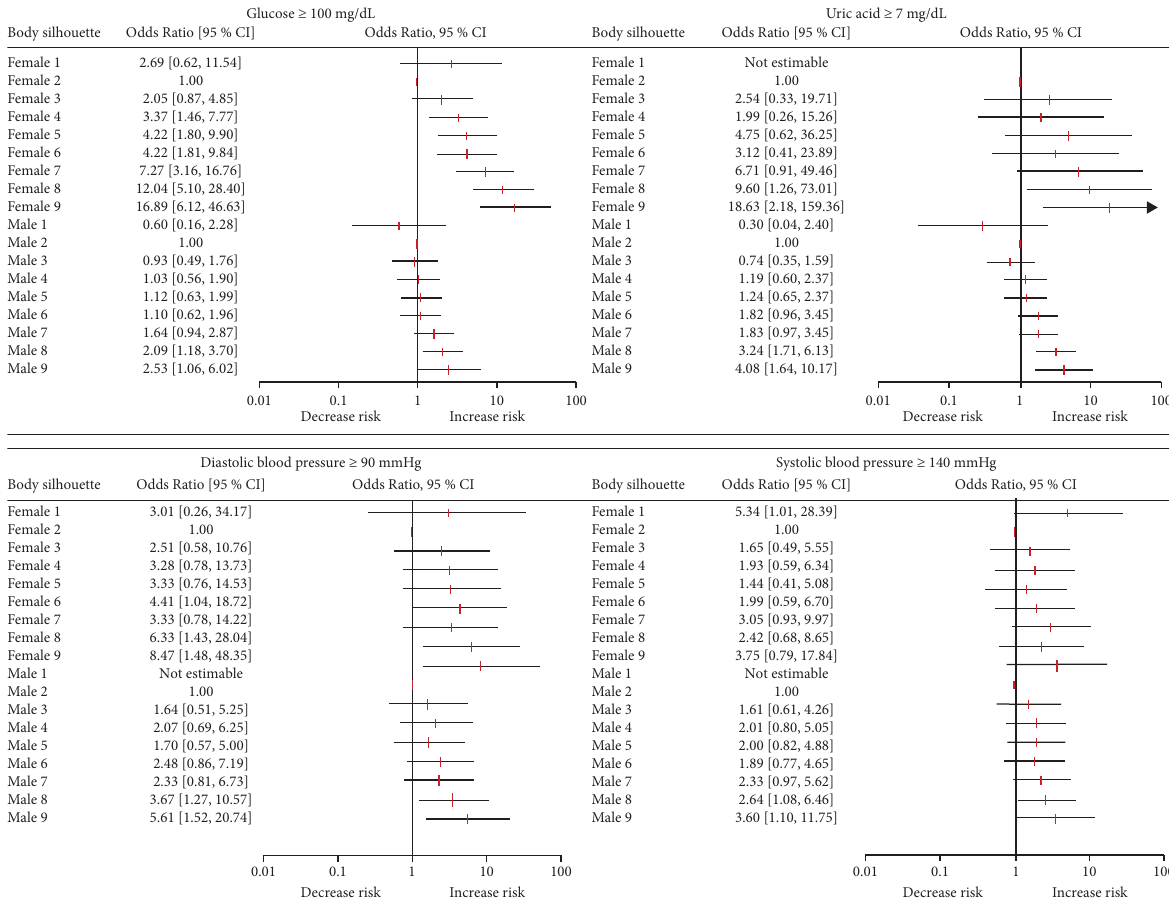
Figure 4: Risk assessment of glucose ≥ 100mg/dL, uric acid ≥ 7mg/dL, diastolic blood pressure ≥ 90mmHg, and systolic blood pressure ≥ 140mmHg, for each self-reported body silhouette for both females and males. All models were adjusted by